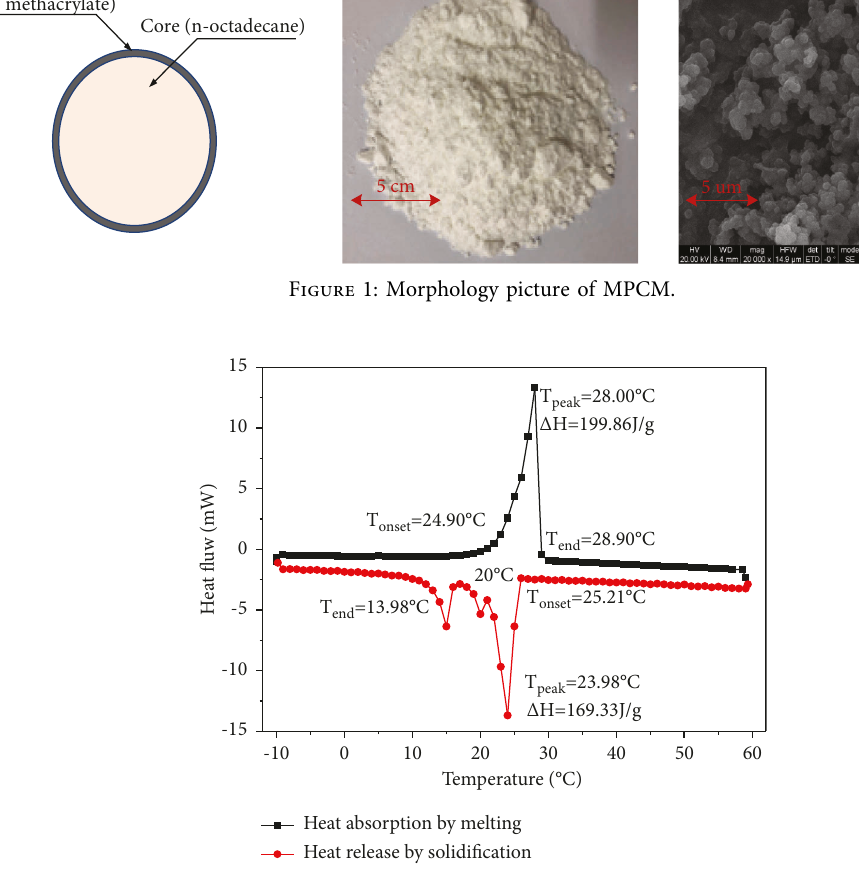
Figure 2: Heat flux curve with temperature during its melting and curing process. Table 2: Physical properties of cement.